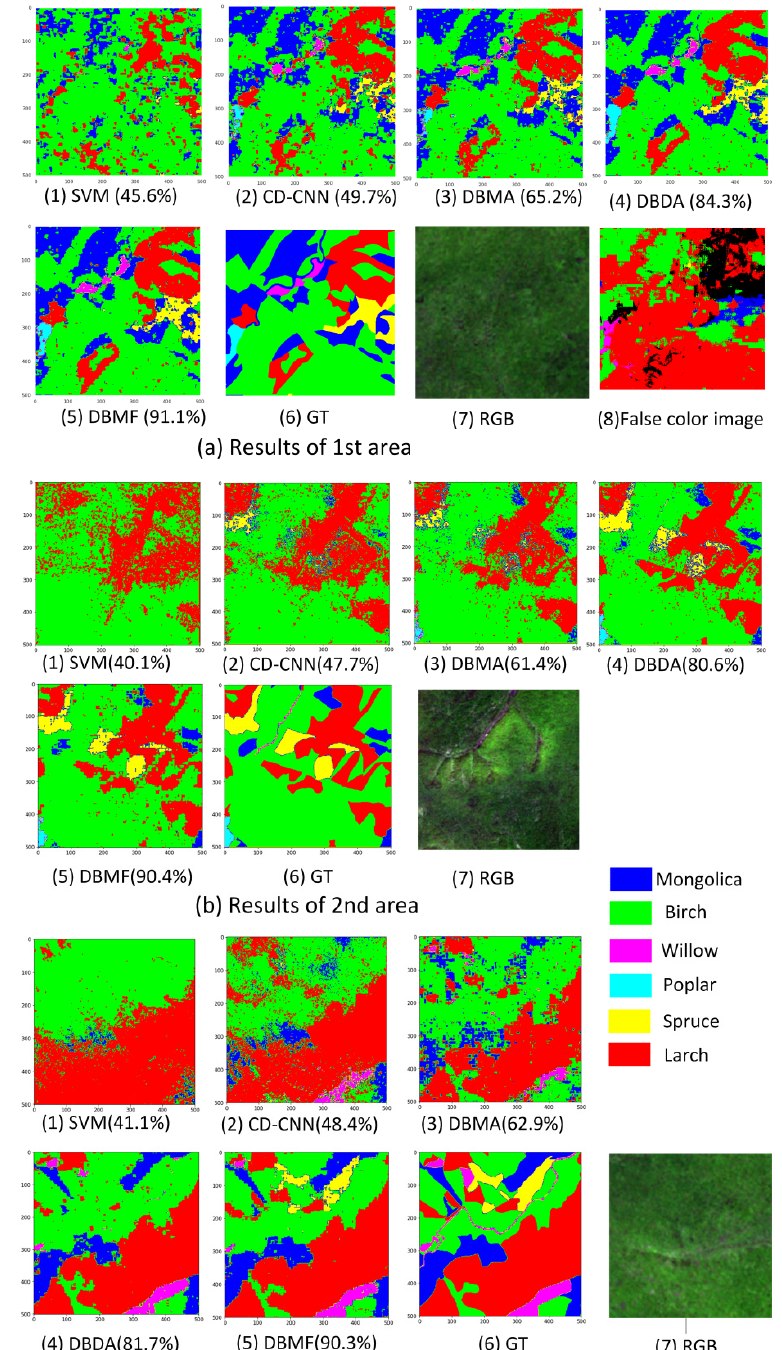
Figure 8. Full classification maps on tree species with a multi-source dataset of the three study areas obtained by (1) SVM, (2) CD-CNN, (3) DBMA, (4) DBDA, (5) DBMF, (6) ground truth, and (7) wrong method.